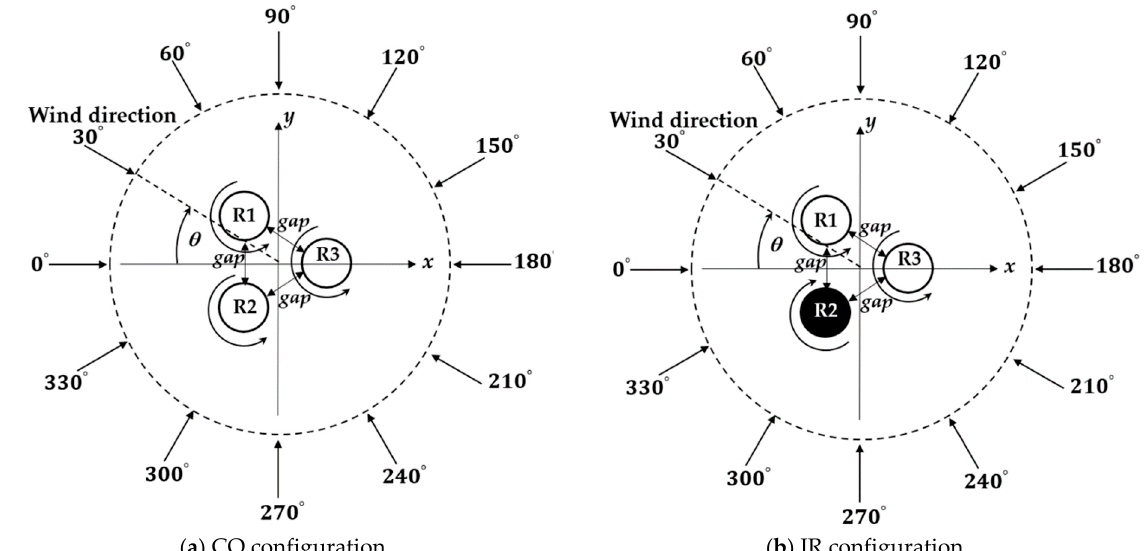
Figure 17. Definition of 12 wind directions in the two configurations in the cases of three-rotor clusters: ( a ) co-rotation (CO) configuration; ( b ) inverse rotation (IR) configuration.